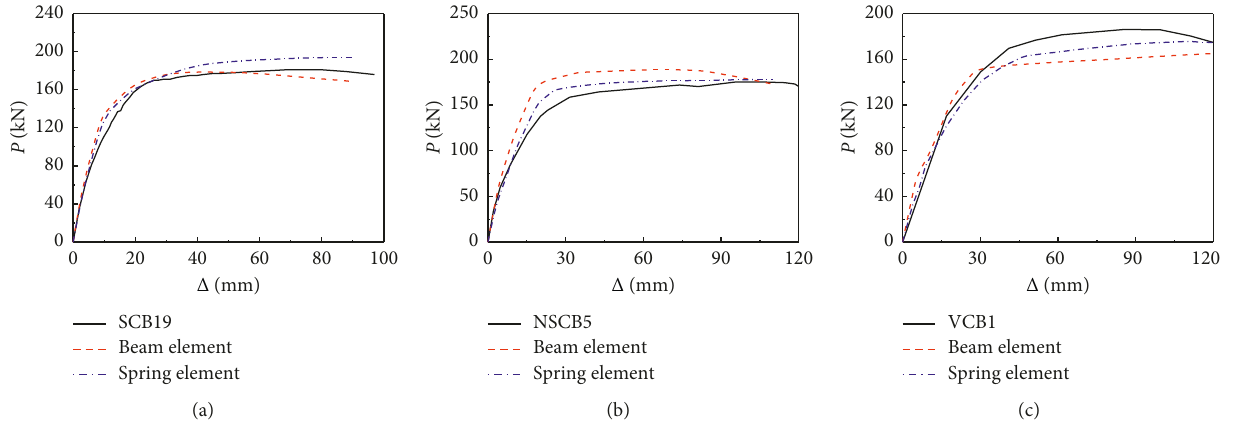
Figure 9: Comparison between the calculated and tested load-deformation curves of a composite beam. (a) SCB19 (present study), (b) NSCB5 (Nie and Cai [5]), and (c) VCB1 (Vasdravellis et al. [11]).